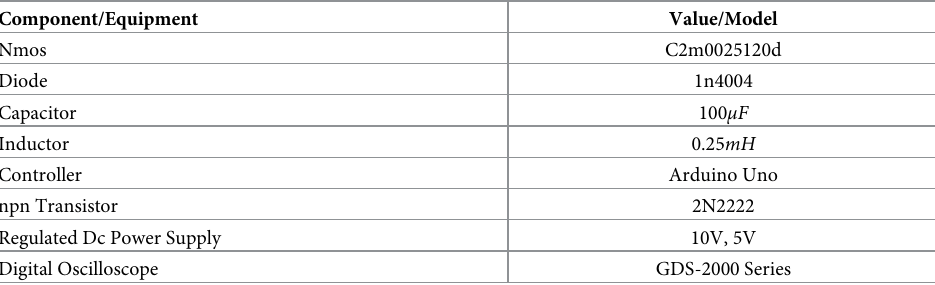
Table 3. List of components used for lab testing.